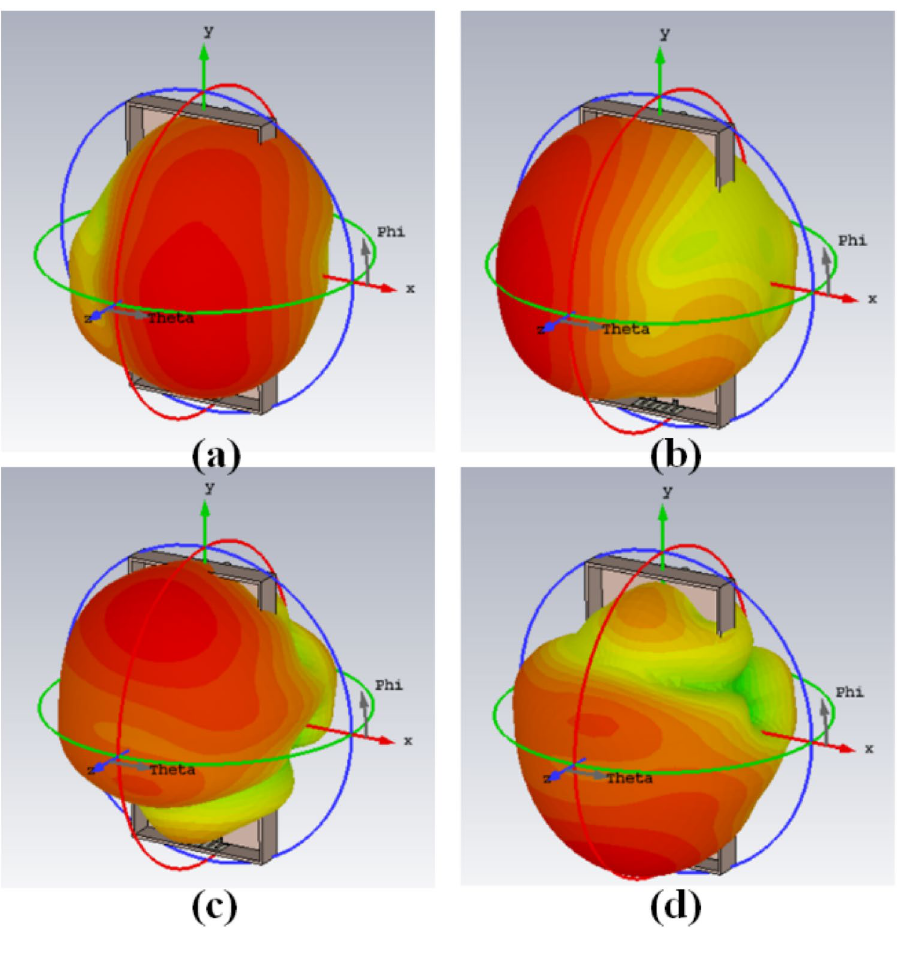
Figure 27. Proposed 8 Members mobile frame-based MIMO antenna 3D radiation patterns simulated results ( a ) Ant 1, ( b ) Ant 2, ( c ) Ant 5, ( d ) Ant 6.